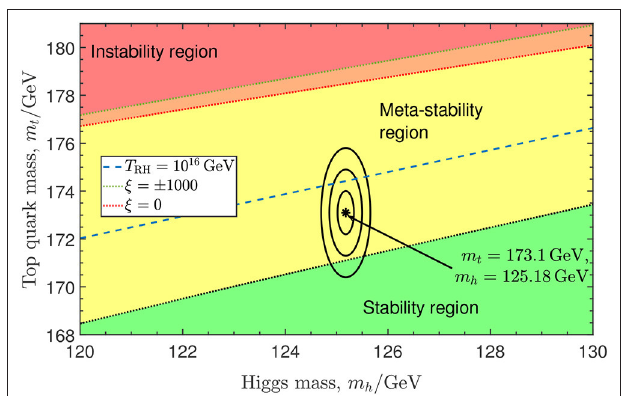
FIGURE 7 | Stability diagram of the Standard Model vacuum state in the pole masses M t , M h of the top quark and Higgs boson, respectively. Ellipses show the 1 σ ,2 σ ,3 σ confidence intervals for M t and M h around their central values from Tanabashi et al. (2018). In the green region, the current vacuum is absolutely stable, in the yellow region it satisfies the bound (5.9), and in the red region it is so unstable that it would not have survived until the present day. The instability boundary includes gravitational backreaction ( Rajantie and Stopyra, 2017 ) and is shown for ξ 0 and ξ 1000 of the non-minimal = = ± curvature coupling. The blue dashed line shows the instability bound (5.62) obtained by taking the thermal history of the Universe into account ( Delle Rose et al., 2016) and assuming a high reheat temperature T RH 10 16 GeV. For = lower reheat temperatures, the instability bound becomes weaker, and approaches the red dotted line as T RH →